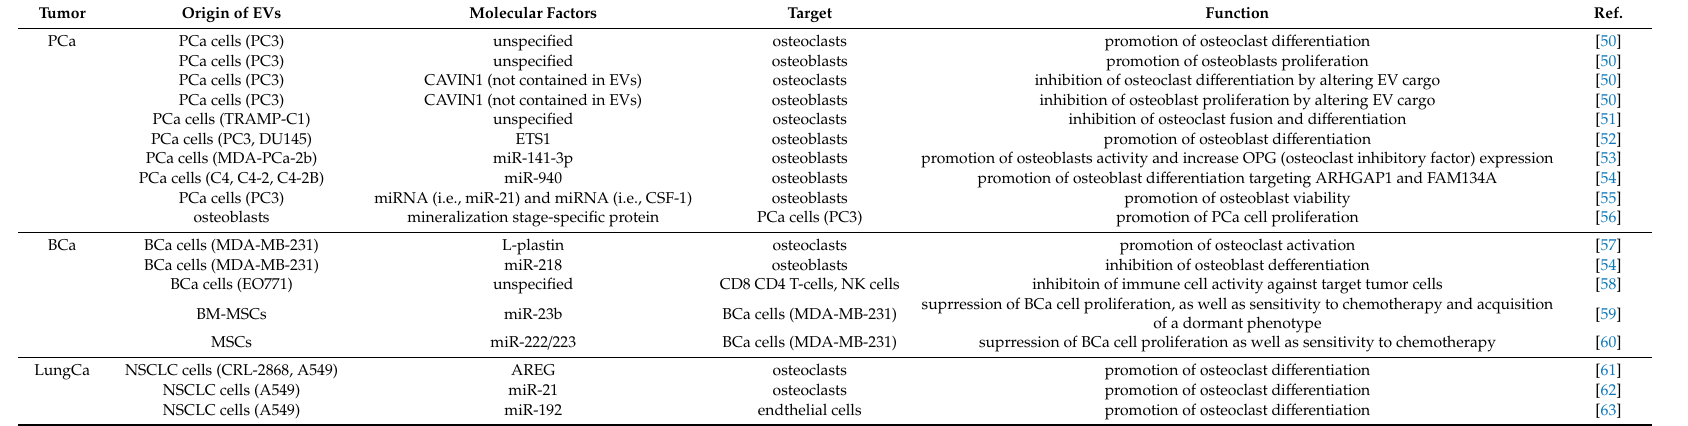
Table 1. List of molecular factors, cell targets and functions involved in EVs in bone metastatic